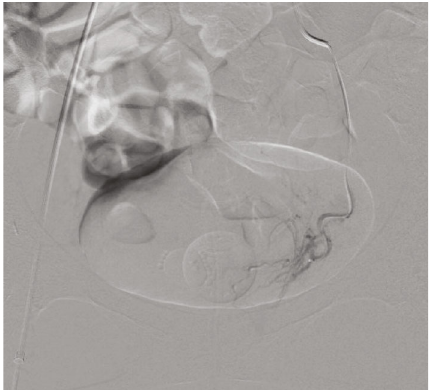
Figure 3: Complete occlusion of the left vaginal pseudoaneurysm by embolization of the left vaginal artery.